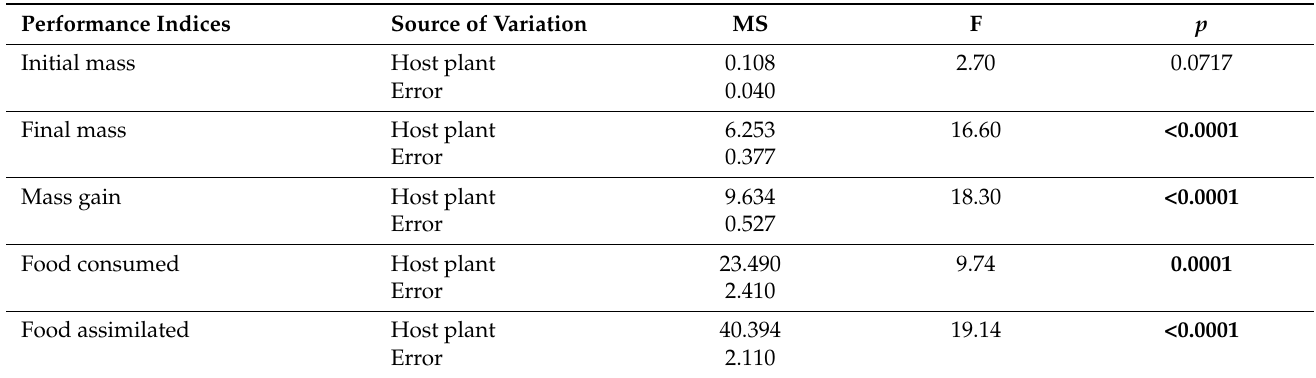
Table 4. MS, F and p values from one-way ANOVA for performance indices. Host plant was fixed factor. Degrees of freedom: df = 2 for host plant effect, and df = 103 for error term. Significant effects are marked in bold.